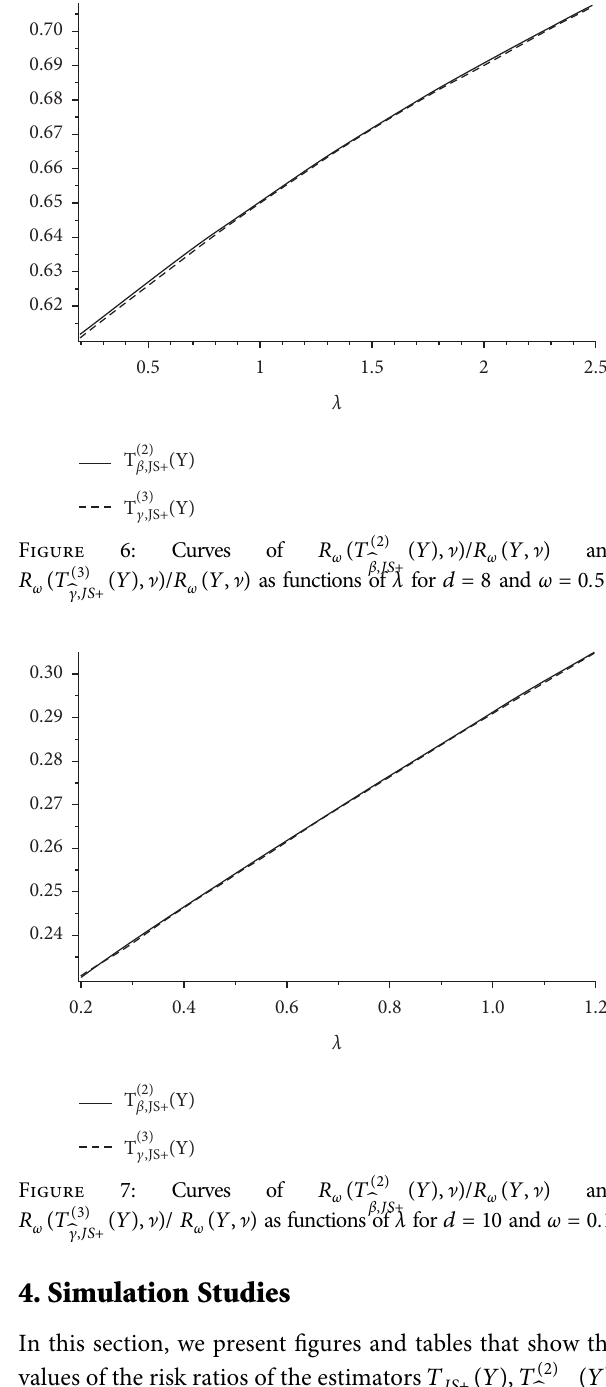
( Y, ] ) as functions of λ for d � 10 and ω � 0 . ω